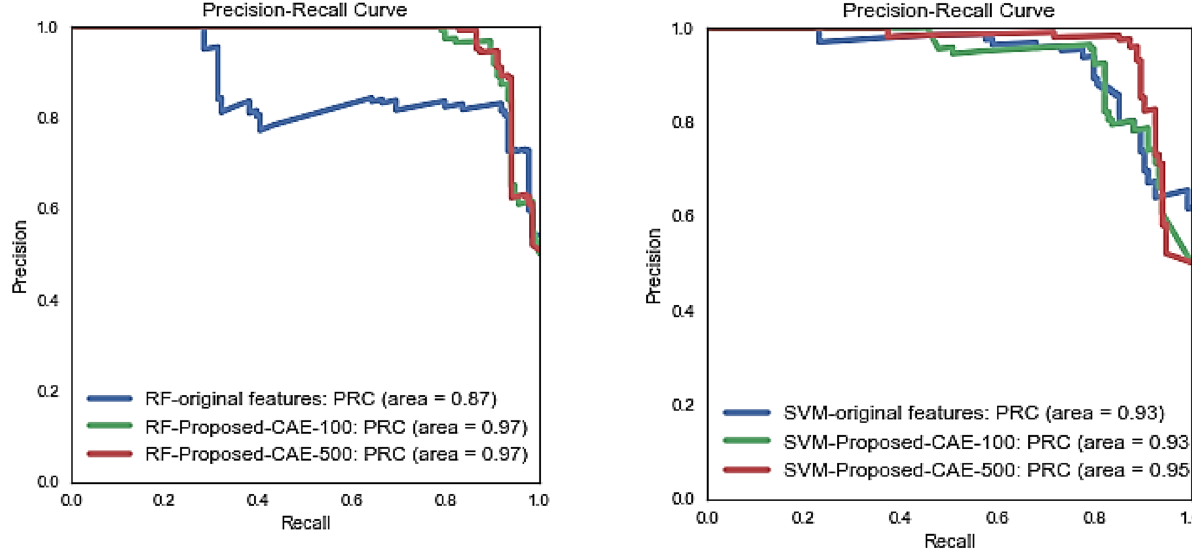
Figure 10. PR-Curve of different feature